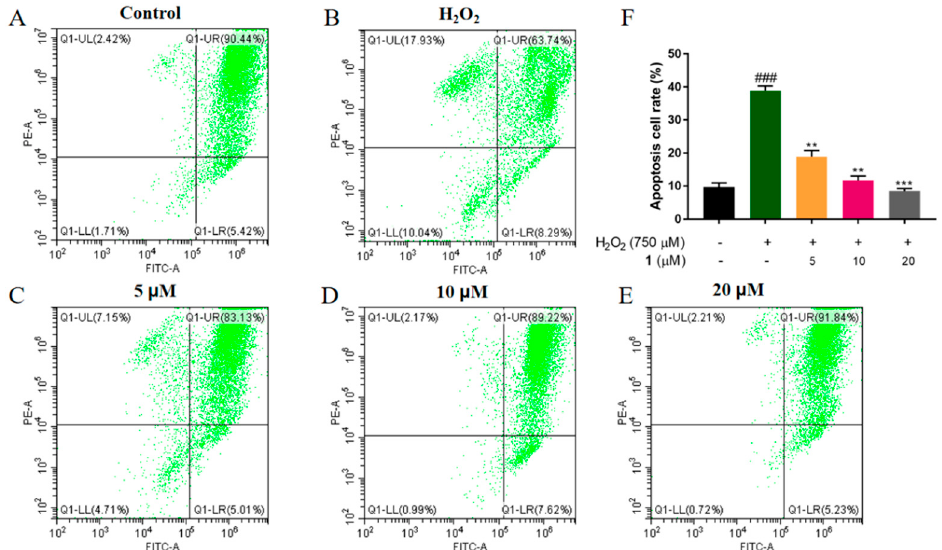
Figure 4. Compound 1 restored the loss of mitochondria membrane potential (MMP) in H 2 O 2 treated PC12 cells. The MMP was assessed using flow cytometry. PC12 cells were treated with ( A ) control; ( B ) H 2 O 2 (750 μ M), and varied concentrations of compound 1 ( C ) (5 μ M); ( D ) (10 μ M); ( E ) (20 μ M) combined with H 2 O 2 (750 μ M) for 24 h; ( F ) Apoptosis cell rate of different groups ### p < 0.005 vs. control cells. ** p < 0.01, *** p < 0.005 vs. H 2 O 2 − treated cells.